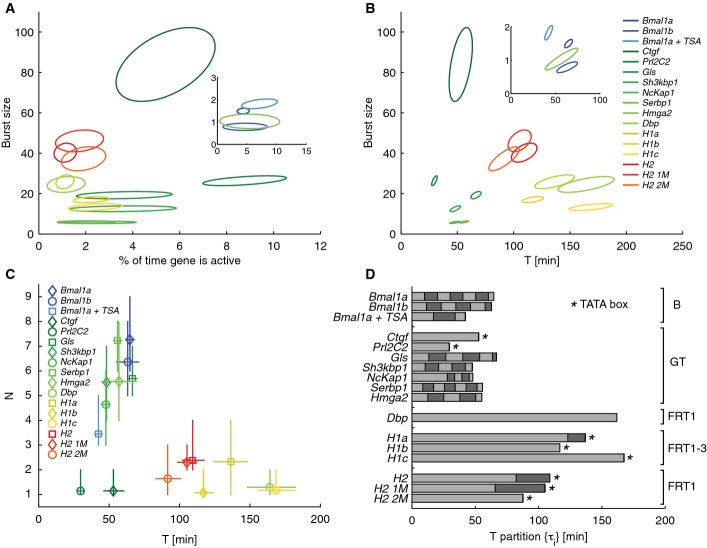
Structure and kinetics of the promoter cycles for the NIH3T3 clones
Burst size vs. the fraction of time the gene is active. Each clone is represented by a 95% confidence ellipse from the posterior distribution. All the analyzed clones burst, characterized by small activity fractions. Burst sizes show a large dynamic range across clones (˜80-fold). Inset: Magnification of the lower left corner.

Burst size vs. the total silent period T. Elongated confidence ellipses reflect the dependence between those two quantities and the mean mRNA. Although the dynamic range of the silent period (˜6-fold) is smaller than for the burst size, it is also gene specific. The synthetic (warm colors) and endogenous (cold colors) promoters cluster in distinct regions.

Number of inactive states vs. T, crosses indicate mean and error bars stand for the 5th and 95th percentiles of the posterior. Endogenous promoters tend to show more inactive steps and shorter cycle times (cluster around N˜6 and T˜60 min) compared to synthetic promoters (cluster around N˜1–2 and T˜130 min).

Partitioning of the silent period for the optimal models. The light and dark bars show the mean durations of each sub-step. Partitions in endogenous promoters tend to be more uniform compared to the synthetic promoters. Average inactive times for endogenous promoter are around 10 min, whereas synthetic promoters have average inactive times close to 100 min (˜115 min for the first and ˜25 min for the subsequent intervals).